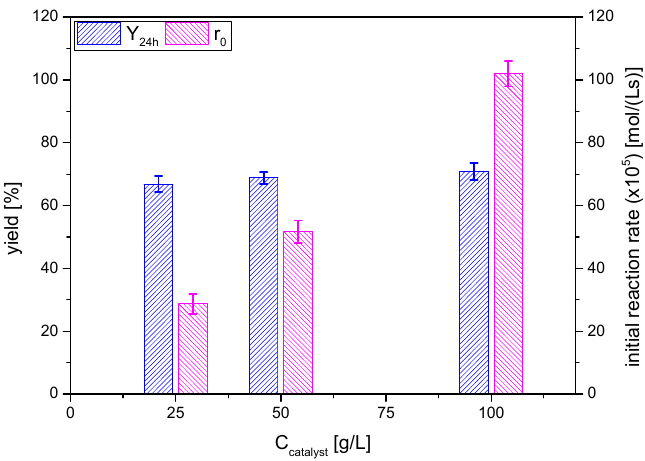
Figure 9. Effect of catalyst amount on the yield of solketal 1 in terms of the yield to the ketal 1 at 24 h and the initial reaction rate (reaction conditions: acetone/glycerol molar ratio, 6:1; temperature, 25 °C).